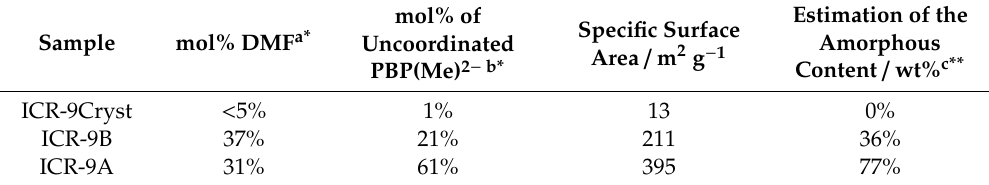
Figure 3. Comparison of the powder XRD patterns of ICR-9Cryst (black), ICR-9B (blue), and ICR-9A (red). The amount of the amorphous phase can be distinguished from the peak / background ratio and the wide peak between 6 and 12° 2 θ . The least amount of the amorphous phase is in the sample of ICR-9Cryst, whereas the largest amount is in the case of ICR-9A. Table 1. Physicochemical properties of ICR-9Cryst, ICR-9A, and